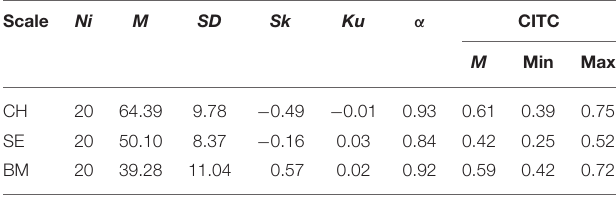
TABLE 9 | Exploratory factor analysis on the STCI–T < 60 > in the construction sample.